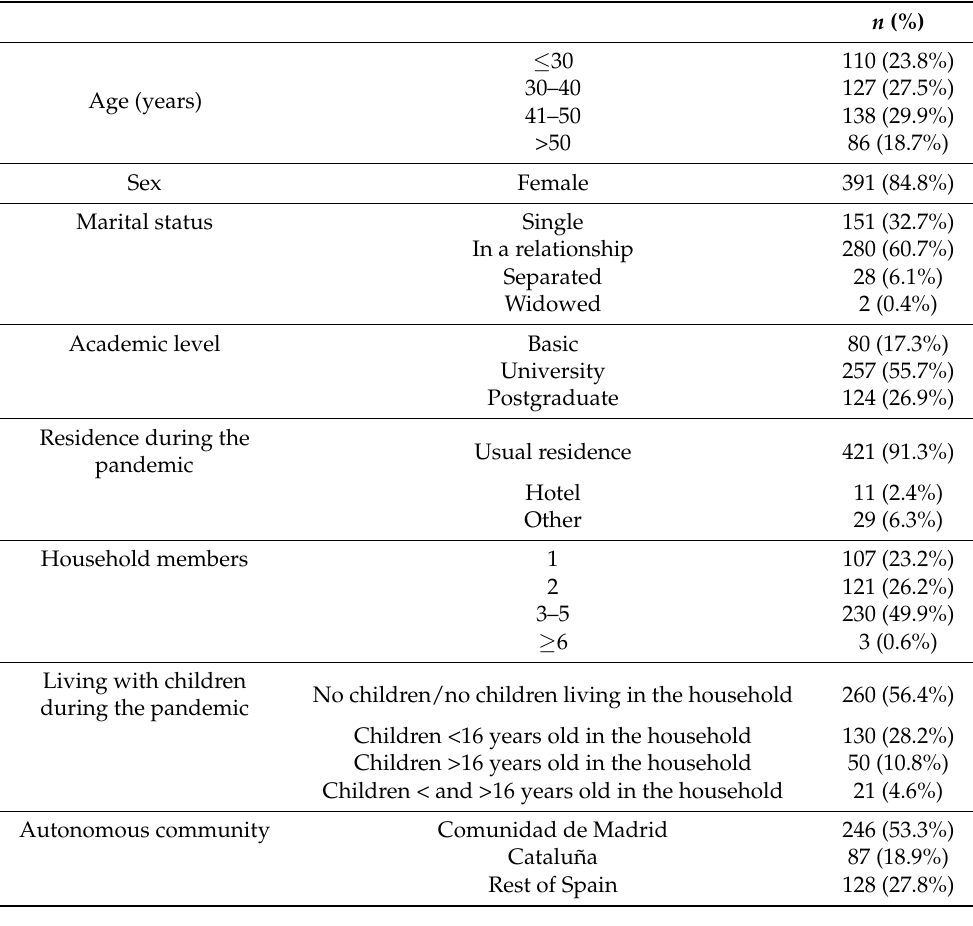
Table 1. Socio-demographic characteristics of the